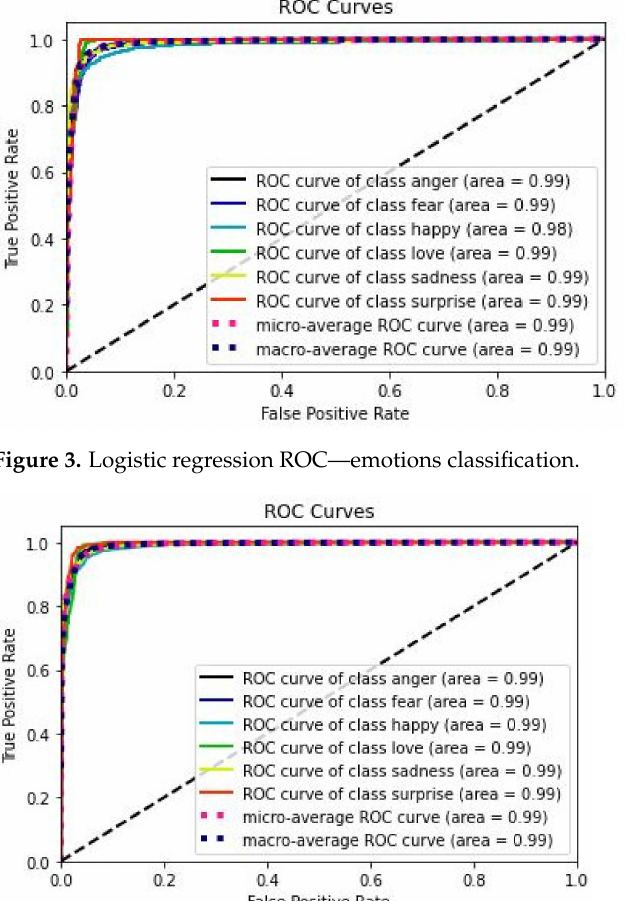
Figure 4. Random forest ROC—emotions classification.